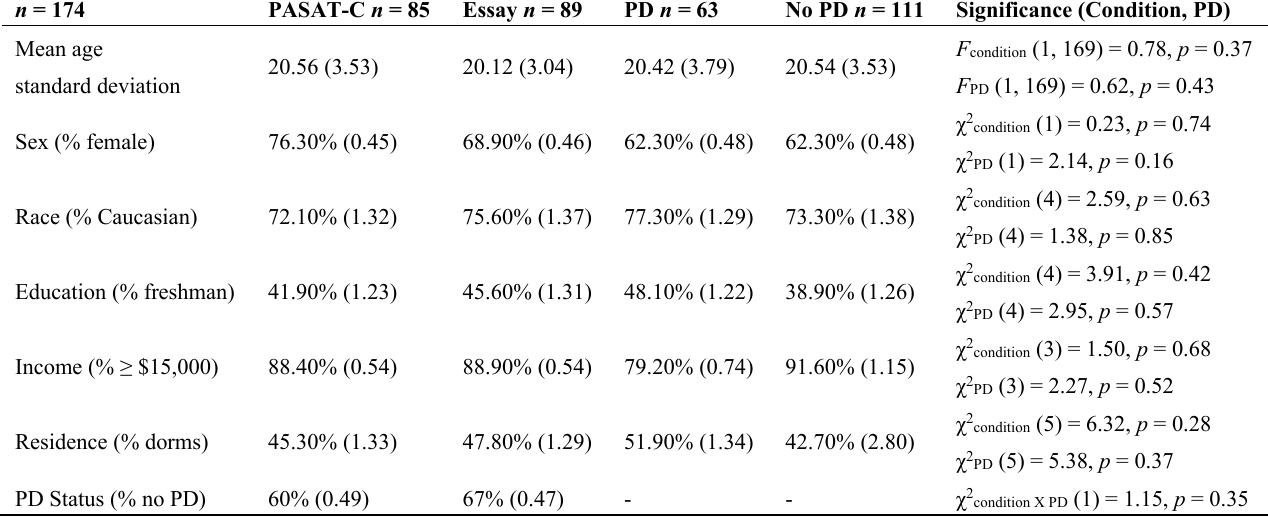
Table 1. Demographic information with ANOVAs and chi-square